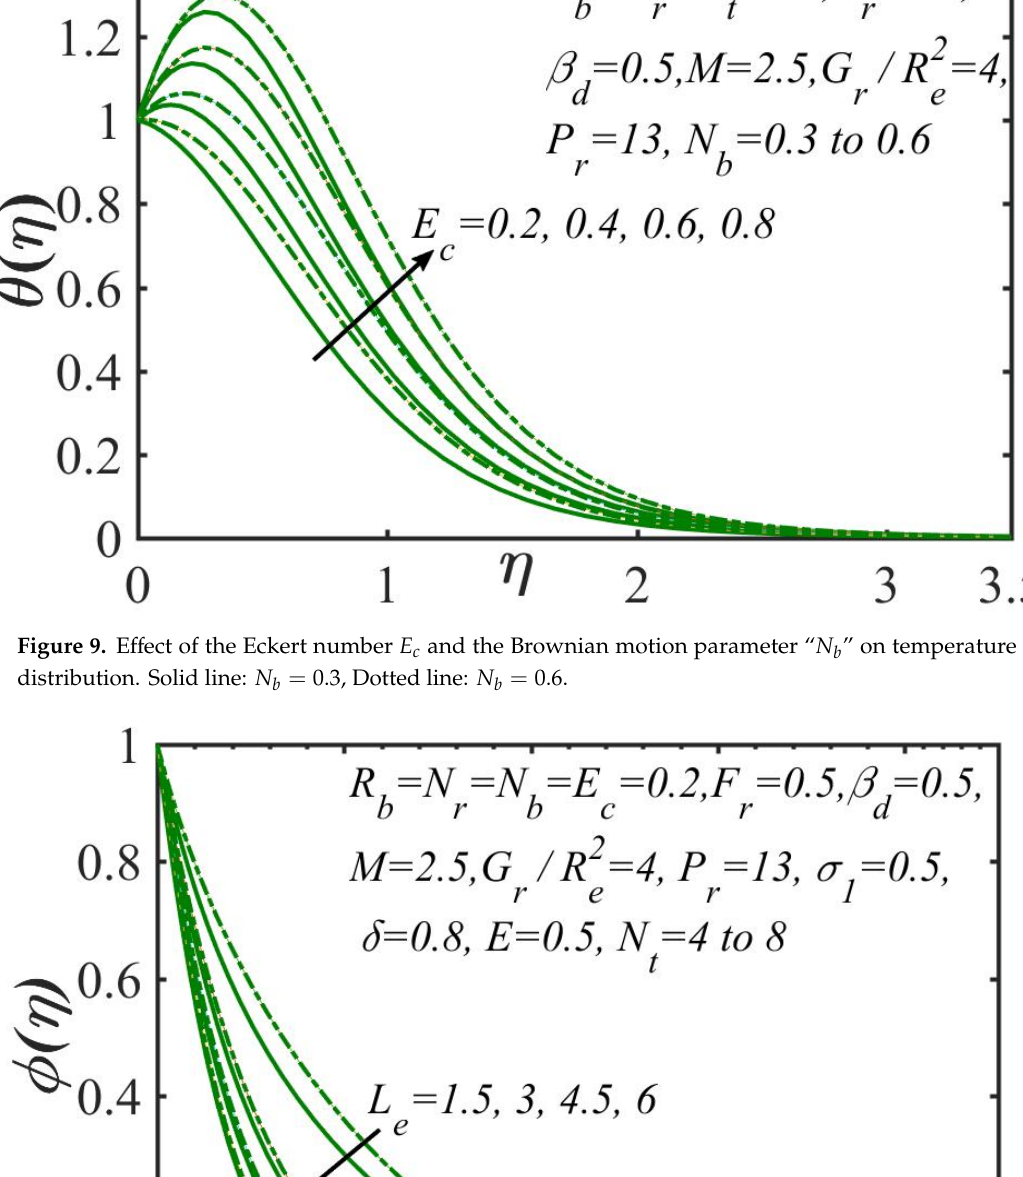
Figure 8. Influence of the thermophoresis parametric quantity (cid:1840) (cid:3047) and the Brownian-motion parameter “ (cid:1840) (cid:3029) ” on temperature distribution. Solid line: (cid:1840) (cid:3029) = 0.3 , Dotted line: (cid:1840) (cid:3029) = 0.6.